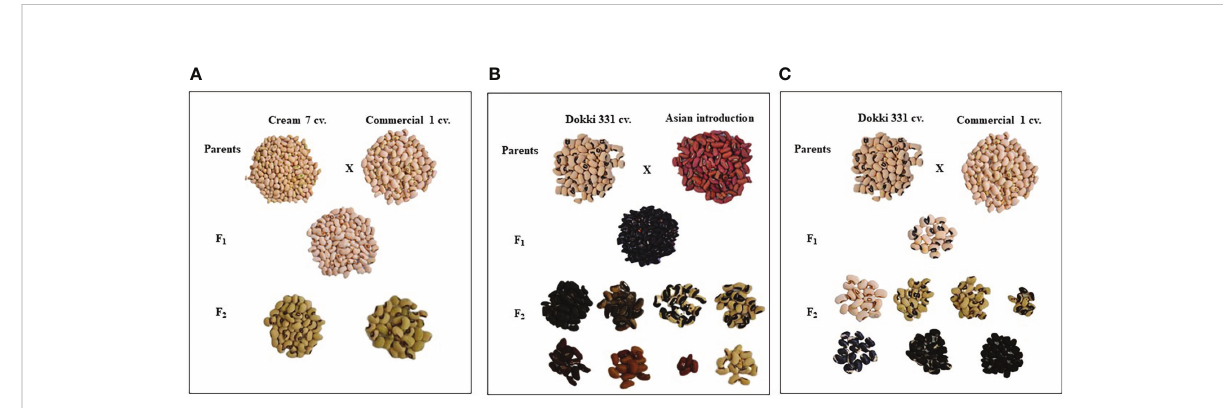
FIGURE 3 The diversi fi cation of seed characteristics of the parental genotypes, F 1 and F 2 of the crosses, (A) Cream 7 cv. x Commercial 1, (B) Dokki 331 cv. x Asian Introduction and (C) Dokki 331 cv. x Commercial 1.